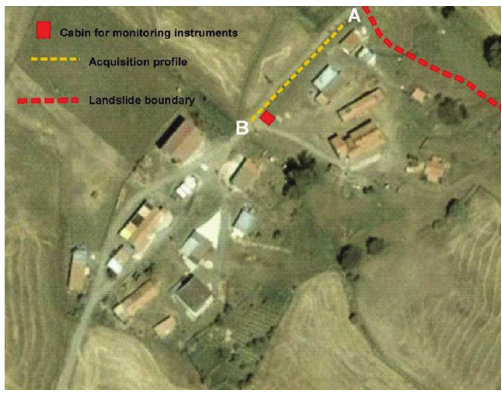
Figure 4: Location of the acquisition profile (from Google Earth,